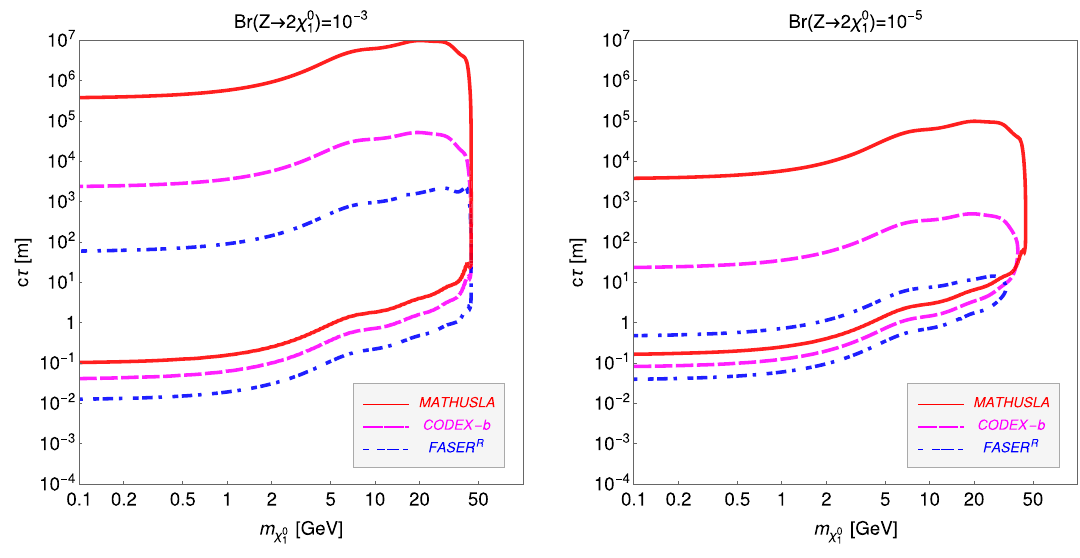
for the 200 m × 200 m MATHUSLA configuration and FASER R , the 1 m radius configuration (referred to as FASER2 elsewhere in this doc-